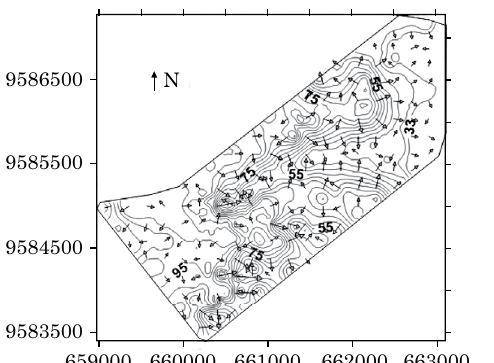
figure 2. Sampling network (+) and points sampled for external validation (○) in the agrarian reform